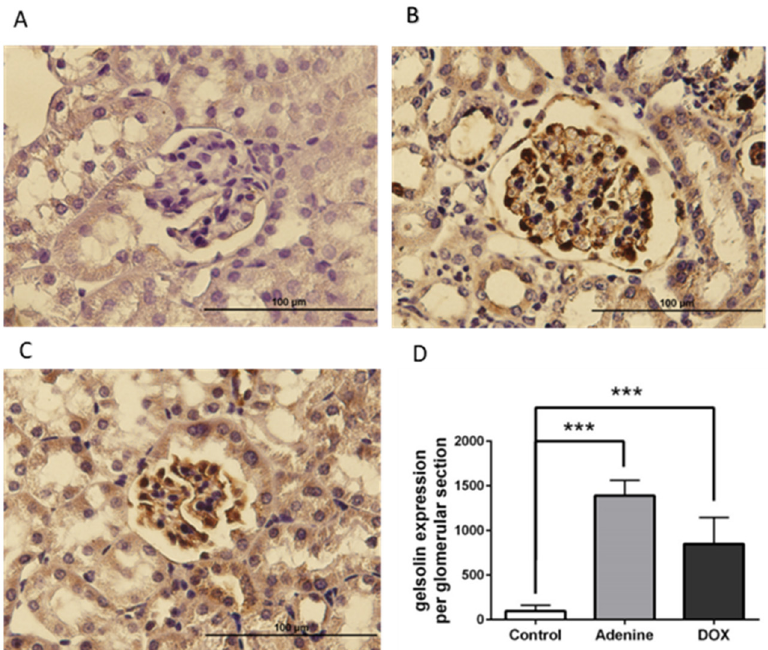
Figure 7. Histological analysis of gelsolin expression in mouse glomeruli. ( A ) Immunohistochemistry staining of gelsolin expression in kidney sections of control mice. (Magnification: 400×). ( B ) Immunohistochemistry staining of gelsolin expression in kidney sections of mice injected with 0.25% adenine. (Magnification: 400×). ( C ) Immunohistochemistry staining of gelsolin expression in kidney sections of mice injected with doxorubicin. (Magnification: 400×). ( D ) Quantitative comparison of gelsolin induction after saline, adenine, and doxorubicin injection. ***, p < 0.001.